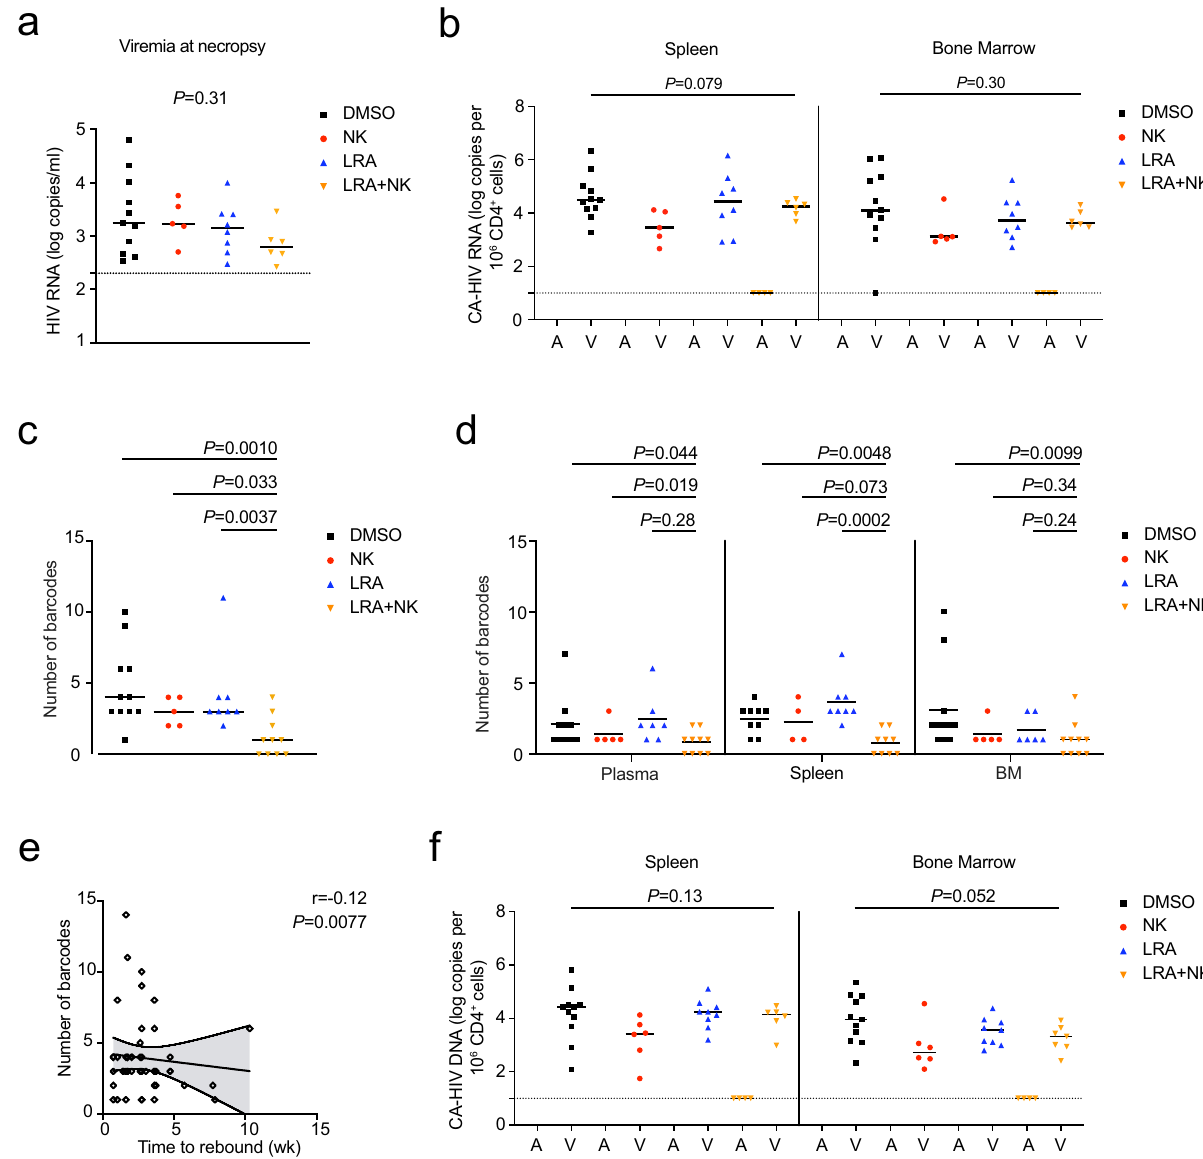
Fig. 6 Levels of viral RNA, barcode diversity, and HIV DNA from infected mice treated with SUW133 and NK cells. a Plasma viral loads of rebounding mice. n = 11 biologically independent animals in DMSO (black) group, n = 5 biologically independent animals in NK only (red) group, n = 8 biologically independent animals in LRA only (blue) group, n = 6 biologically independent animals in LRA plus NK (orange) group. b Cell-associated “ CA ” HIV RNA from the spleen and bone marrow “ BM ” of mice that were aviremic “ A ” or had rebound viremia “ V ” at necropsy. c , d Number of unique barcodes quanti fi ed by deep sequencing of viral RNA from pooled organs per mouse ( c ) or from the plasma, spleen, and BM of each mouse ( d ). e Scatterplot of a number of unique barcodes per mouse and time to rebound among all mice that rebounded after ART interruption. n = 48 biologically independent rebounding animals. Lines are linear predictions of time to rebound on the number of barcodes. The 95% con fi dence intervals of the fi tted values are shown by gray areas. r Pearson correlation coef fi cient. f Total CA-HIV DNA from the spleen and BM of mice that were aviremic or had rebound viremia at necropsy. n = 11 biologically independent animals in DMSO only group, n = 5 biologically independent animals in NK only group, n = 8 biologically independent animals in LRA only group, n = 10 biologically independent animals in LRA plus NK group ( b – d , f ). Black dotted line indicates the detection limit of 2.3 log RNA copies per ml ( a ) or 1.0 log RNA or DNA copies ( b , f ). Horizontal bars represent the means ( a – d , f ). P values were calculated using one-way ANOVA Kruskal – Wallis test ( a , b , f ), two-tailed Mann – Whitney ( c , d ), or Pearson correlation test ( e ). Results are pooled from two independent experiments. Source data are provided as a Source Data fi